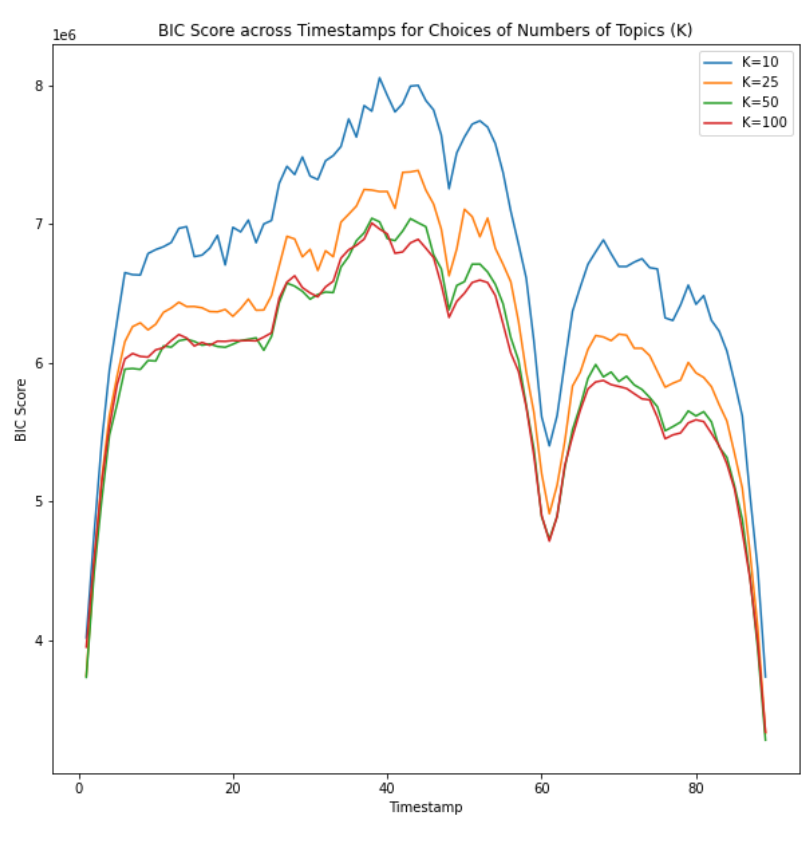
Figure H.4. Bayesian information criteria (BIC) scores across timestamps for different choices of the numbers of